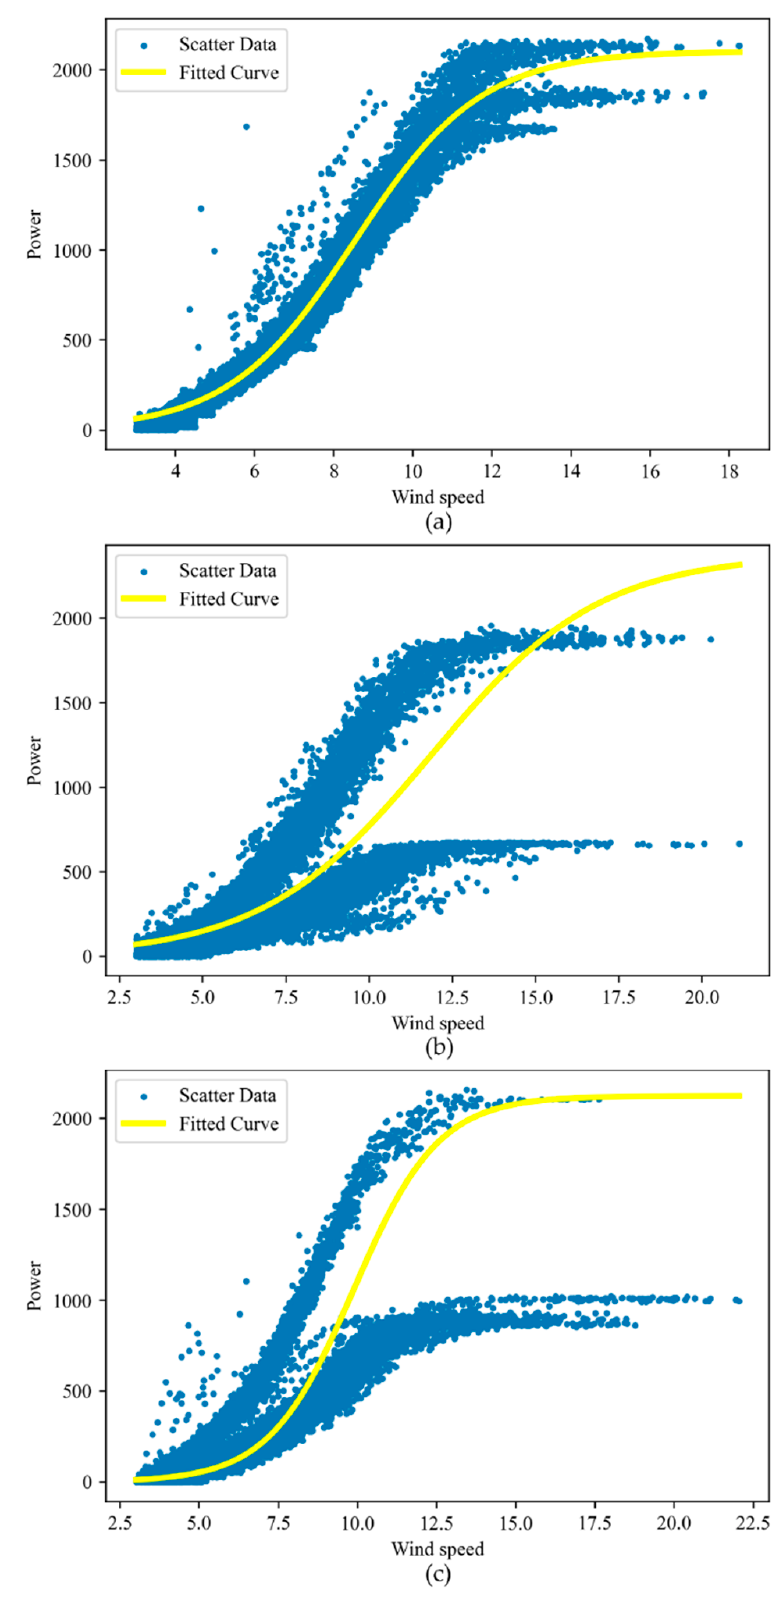
Figure 7. Curve fitting results: ( a ) #1 wind turbine; ( b ) #2 wind turbine; ( c ) #3 wind turbine. Table 2. The result of solving for the optimal parameters.